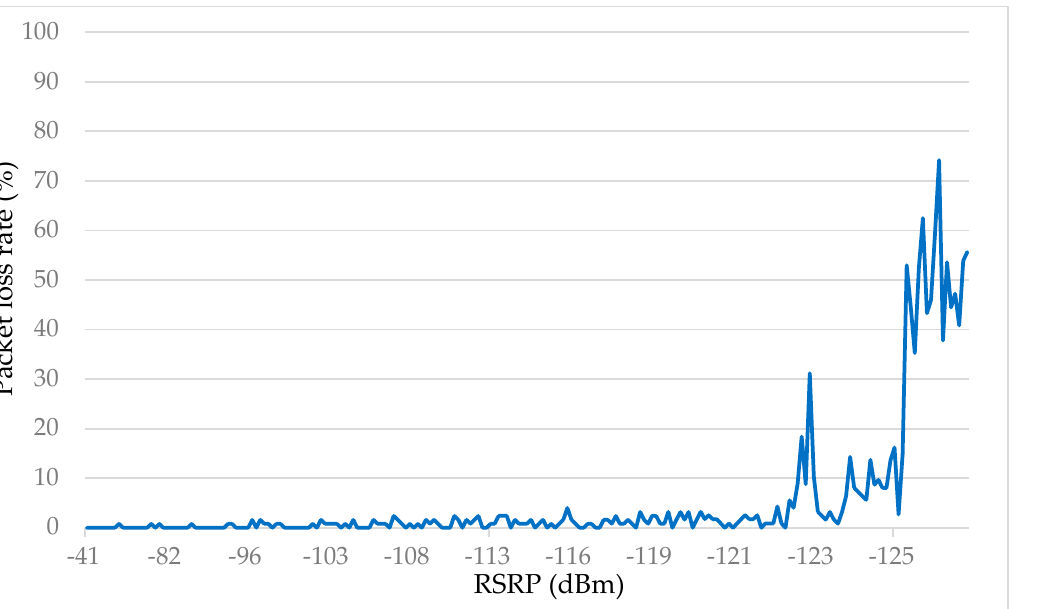
Figure 7. The relationship between MOS and RSRP for video conference service for UE.